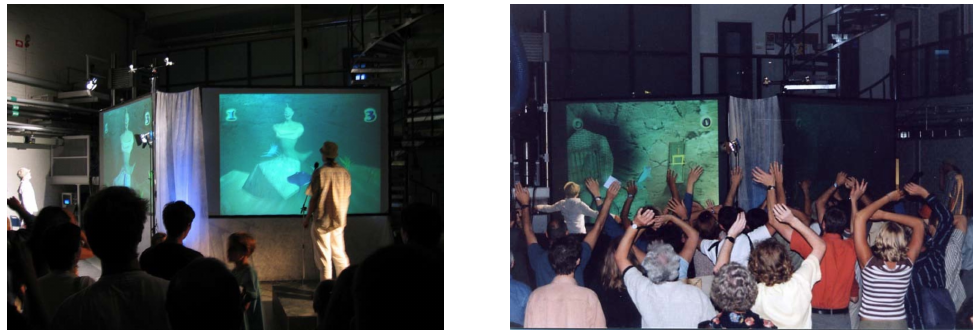
Figure 16. Ghost in a cave : The players’ avatars have entered the “happy” cave. The motion input player on the left and the voice input player on the right ( left image). Team 1 is helping the motion player to reach the gate of the cave displayed on the screen to the left ( right